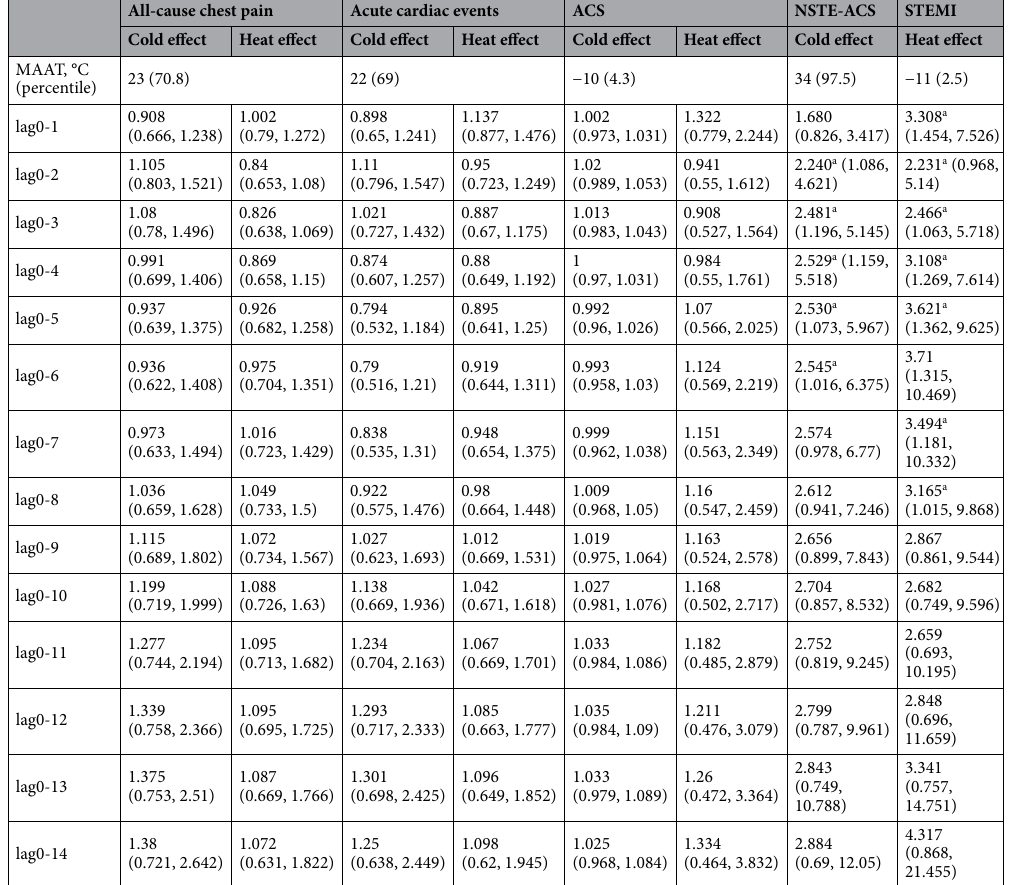
Table 4. The cumulative effect estimates of extreme apparent temperature at different lag day(s) with the reference of the Minimum Admission Apparent Temperature (MAAT), by different chest pain categories. ACS, Acute coronary syndrome; STEMI, ST-segment elevation myocardial infarction; NSTE-ACS, Non-STEMI acute coronary syndrome. a Relative risk values are statistically